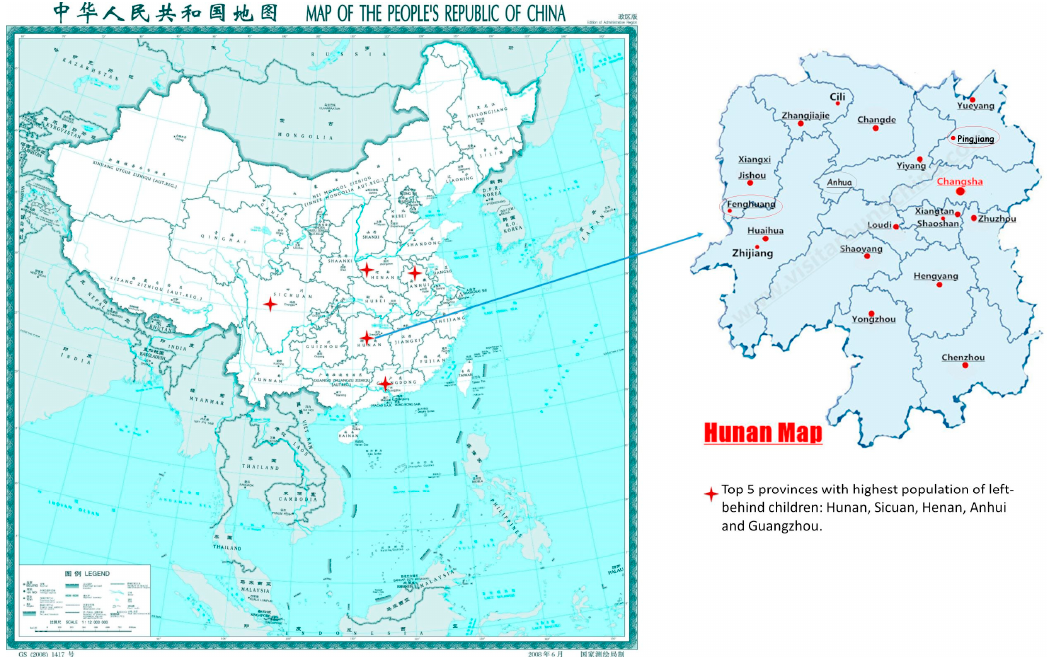
Figure 1. Location map of the sampling sites.